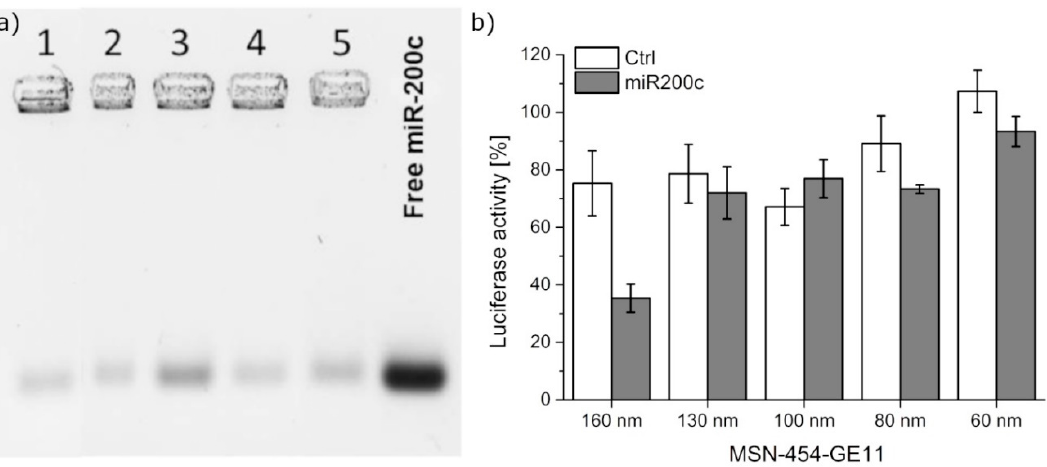
Figure 6. ( a ) Gel electrophoresis of samples MSN160 nm-454-GE11 (1), MSN130 nm-454-GE11 (2), MSN100 nm-454-GE11 (3), MSN80 nm-454-GE11 (4), and MSN60 nm-454-GE11 (5). ( b ) Gene silencing of T24 / eGFPLuc-200cT cells transfected with MSN-454-GE11 containing either Ctrl (white) or miR200c (grey). After an incubation time of 45 min, cells were washed. At 48 h after transfection, gene-silencing e ff ects were